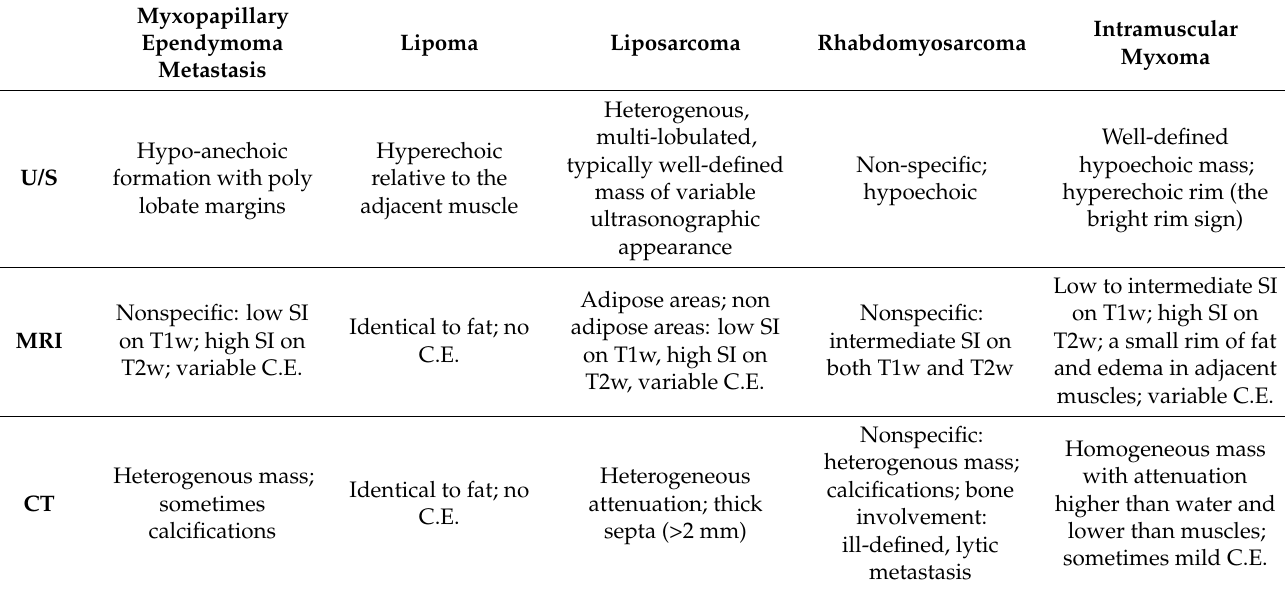
Table 3. Radiologic features of lesions commonly involving paravertebral